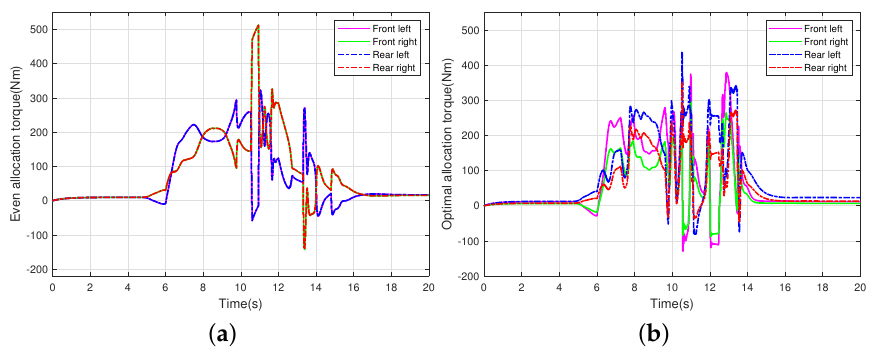
Figure 7. Torque distributions of the even allocation and optimal allocation in low-adhesion DLC conditions. ( a ) Torque distribution with even allocation in low-adhesion DLC conditions. ( b ) Torque distribution with optimal allocation in low-adhesion DLC conditions.